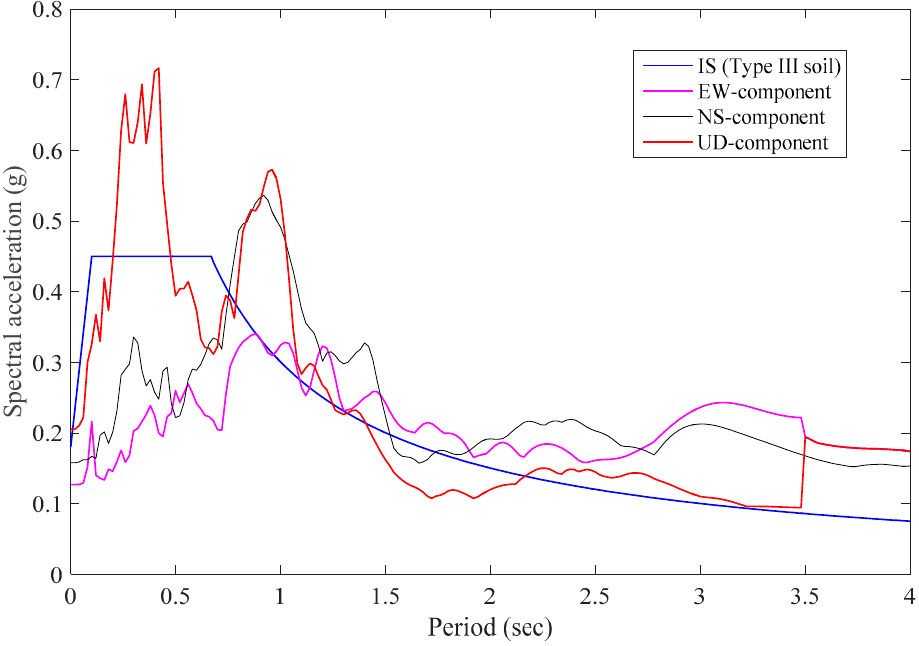
Figure 8. Response spectra of the recorded accelerogram at the Department of Mines and Geology plotted along with Indian Standard code response spectrum for soft soil. In the figure, EW indicates the east ‐ west component of acceleration, NS indicates the north ‐ south component of acceleration, and UD indicates the vertical acceleration component.